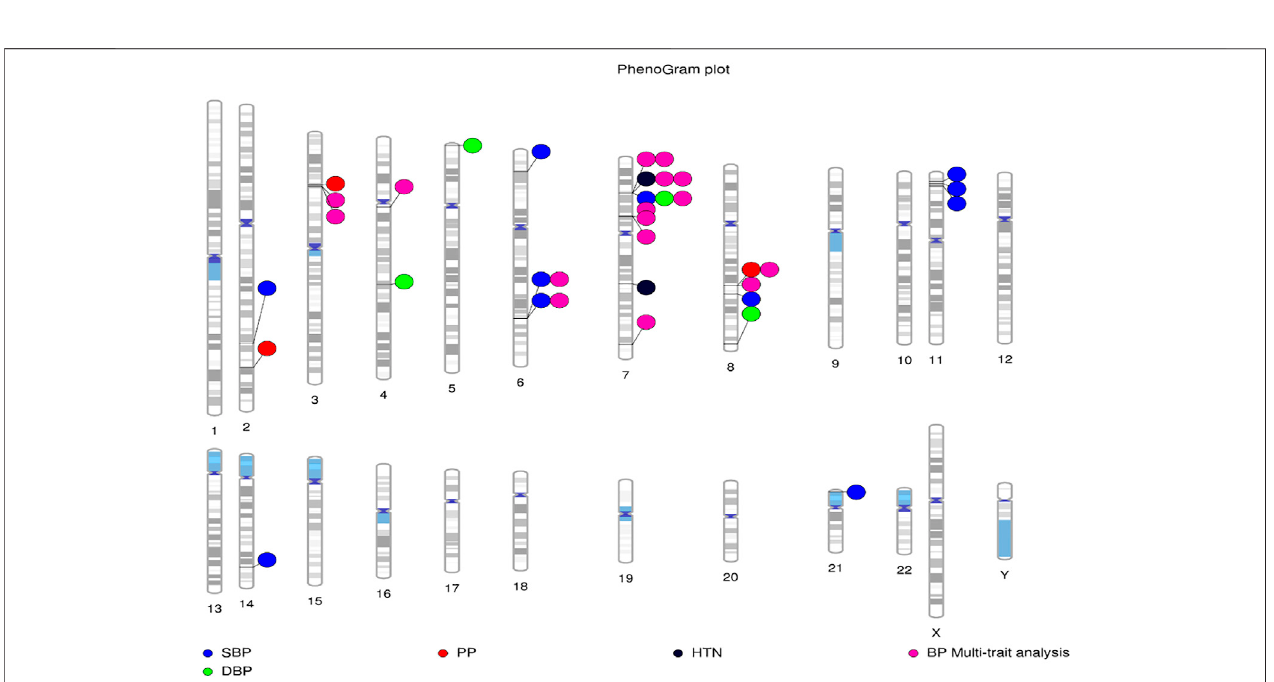
FIGURE 2 | Distribution of loci identi fi ed by GWAS for BP-associated traits in African-ancestry populations. Lines are plotted on the chromosomes corresponding to the base-pair location of each SNP, and the coloured circles represent the associated phenotype(s). Constructed using PhenoGram (Wolfe et al., 2013).